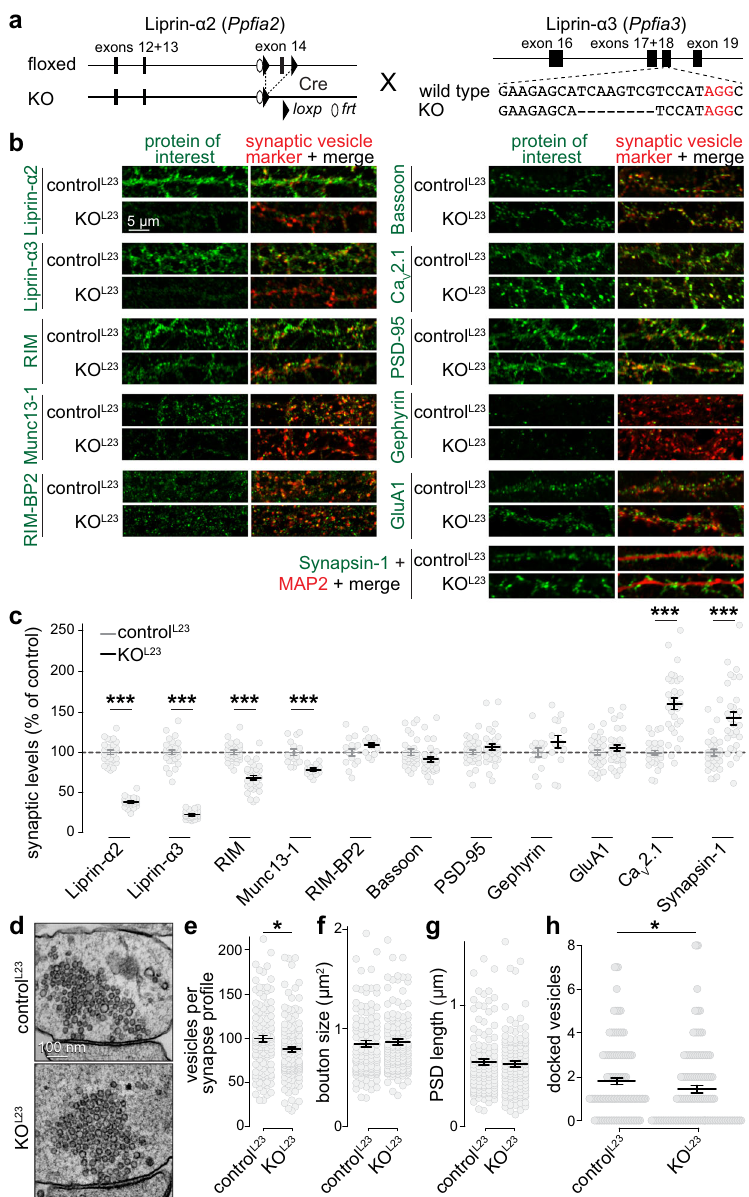
Fig. 4 Liprin- α 2/ α 3 double knockout alters presynaptic composition and ultrastructure. a Schematic for simultaneous knockout of Liprin- α 2 and - α 3. Mice in which Liprin- α 2 can be removed by cre recombination (Liprin- α 2 f/f ) were generated and crossed to previously published constitutive Liprin- α 3 knockout mice (Liprin- α 3 − / − , generated by CRISPR/Cas9-mediated genome editing, deleted sequence is represented with dashes) 19 . Cultured hippocampal neurons of Liprin- α 2 f/f /Liprin- α 3 − / − mice infected with lentivirus expressing cre recombinase (KO L23 ) were compared to neurons of Liprin- α 2 f/f x Liprin- α 3 + / − mice infected with lentiviruses that express an inactive cre recombinase (control L23 ). b , c Example confocal images ( b ) and quanti fi cation ( c ) of neurons immunostained for Liprin- α 2, Liprin- α 3, RIM, Munc13-1, RIM-BP2, Bassoon, Ca V 2.1, PSD-95, Gephyrin, or GluA1 along with Synaptophysin (for Munc13-1, RIM-BP2, and Gephyrin) or Synapsin (all others) as vesicle marker, or Synapsin-1 and MAP2. Quanti fi cation in c was performed in regions of interest (ROIs) de fi ned by the synaptic vesicle marker and normalized to the average control L23 levels per culture, N = 30 images/ 3 independent cultures per genotype per protein of interest, except for Munc13-1 ( N = 15/3), RIM-BP2 ( N = 14/3), and Gephyrin ( N = 14/3), p values: Liprin- α 2, 2e-16 (***); Liprin- α 3, 2e-16 (***); RIM, 3e-11 (***); Munc13-1, 3e-05 (***); RIM-BP2, 0.54; Bassoon, 0.07; PSD-95, 0.30; Gephyrin, 0.10; GluA1, 0.53; Ca V 2.1, 5e-10 (***); Synapsin, 7e-06 (***). d – h Example electron micrographs of synapses ( d ) and quanti fi cation (per section) of the number of synaptic vesicles ( e ), bouton size ( f ), PSD length ( g ), and number of docked vesicles ( h ) of neurons fi xed by high-pressure freezing followed by freeze substitution, control L23 : N = 111 synapses/2 independent cultures, KO L23 : N = 124/2, p values: e , 0.02 (*); f , 0.51; g , 0.95; h , 0.02 (*). All data were mean ± SEM. Signi fi cance was assessed using Mann – Whitney U tests, except for PSD-95 and Gephyrin in c, for which t -tests were used. All tests were two-sided. For synaptic localization of Liprin- α 1 to - α 4, see Supplementary Fig. 7, for generation of Liprin- α 2 f/f mice and analysis of Synaptophysin levels of the experiments shown in c , see Supplementary Fig.